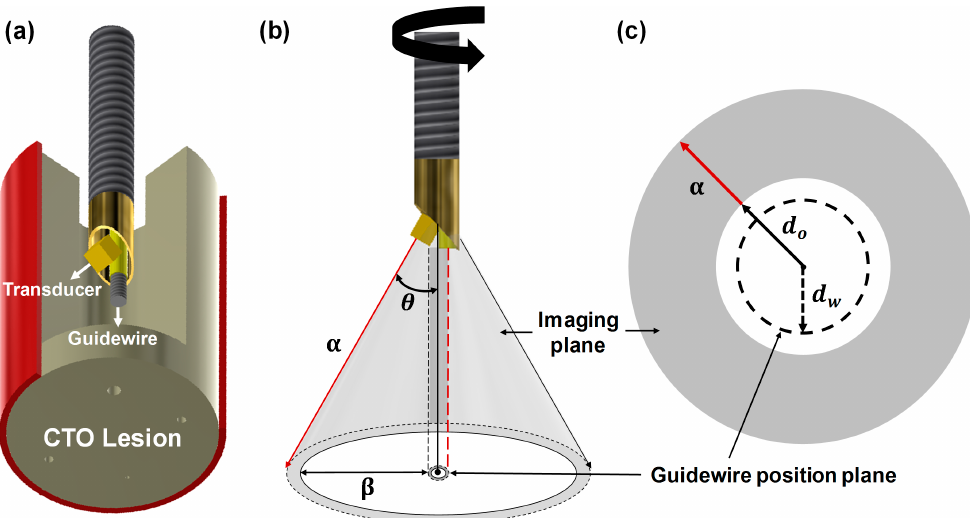
Figure 1. Conceptual illustration of ( a ) the proposed forward-looking intravascular ultrasound (FL–IVUS) transducer consisting of a single-element angled aperture and a guidewire passage, ( b ) the conical imaging plane along the vertical direction of the blood vessel, and ( c ) the FL–IVUS image expected to be displayed on a monitor. α and θ indicate the slant height and semi-vertical angle of the conical imaging plane. β is the closest distance between the imaging plane and the guidewire position plane. d 0 and d W are the distances from the vertex of the cone to the aperture surface and to the center of the guidewire passage, respectively.